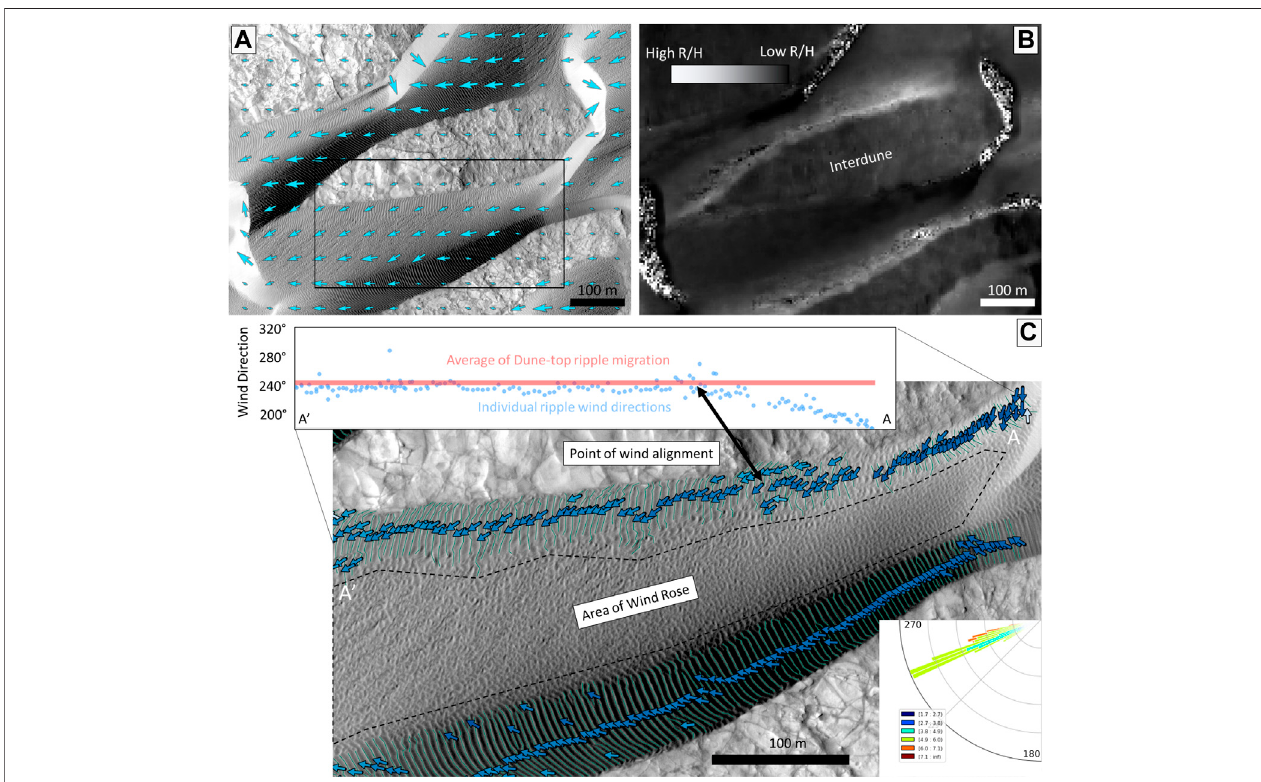
FIGURE12| Imageryandripplemigrationdirections (A) andripplemigrationrateoverduneheight (B) mapsofsiteF. (C) Closerexaminationofthesoutherndune. The rose diagram indicates the direction of ripple motion within the outlined area, showing little change over the dune top. Local winds on the north-facing slope show initialdeviation, thenalignmentwith theregionalwind at thelocationindicatedby theblack arrow. Onthe southern slope, localwinds showconsistent deviation from the regional wind along the slope.